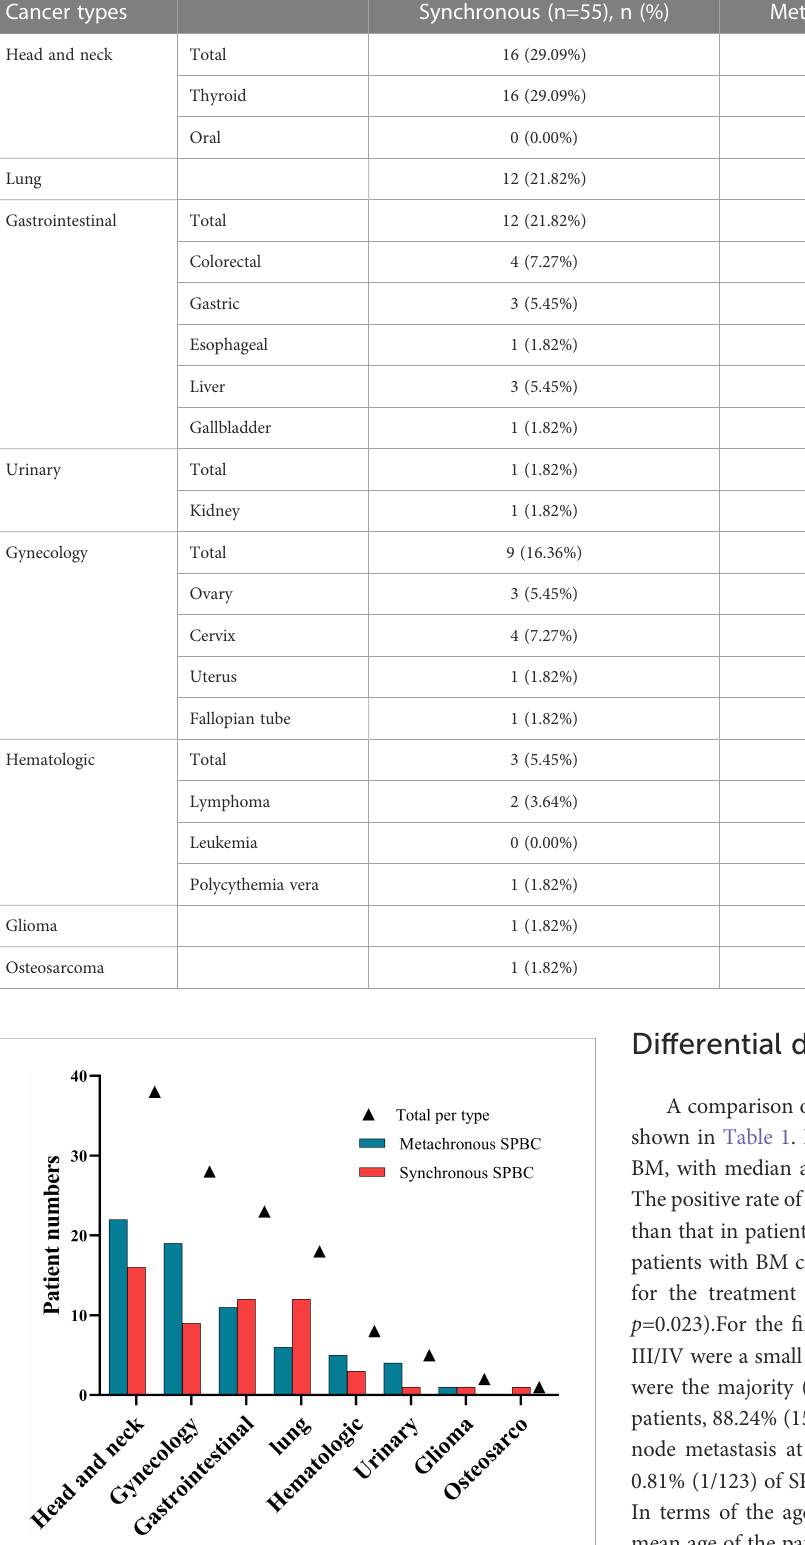
TABLE 2 Numbers and types of primary non-breast malignancy in patients with second primary breast carcinoma. Cancer types